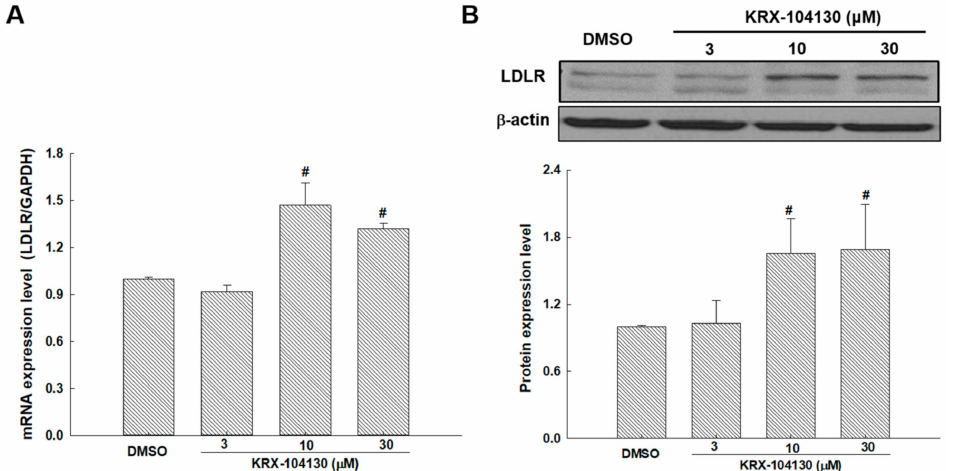
Figure 7. ( A ) mRNA and ( B ) protein expression levels of LDLR treated with 3, 10, and 30 µ M KRX-104130 in the HepG2 cells. # p < 0.05, relative to control ( n = 3).